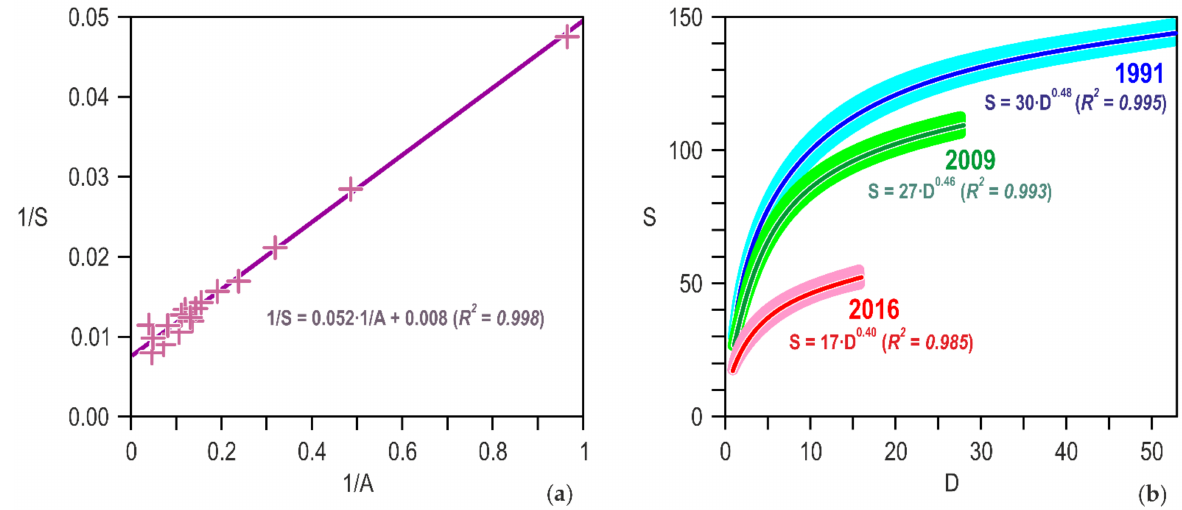
Figure 1. Applications of species-effort relationships: ( a ) an example of plot of the reciprocals of cumulative species number (1/S) against the reciprocals of sample number (1/A) to allow com- puting the theoretical maximum number of species as the reciprocal of the intercept: in this case, 1/0.008 = 125 (from [80], redrawn and modified); ( b ) species–dives curves (with shadowed area representing the 95% confidence intervals) to compare the cumulative number of species S observed in three different years (1991, 2009 and 2016) with a different number of dives D (from [81], redrawn and